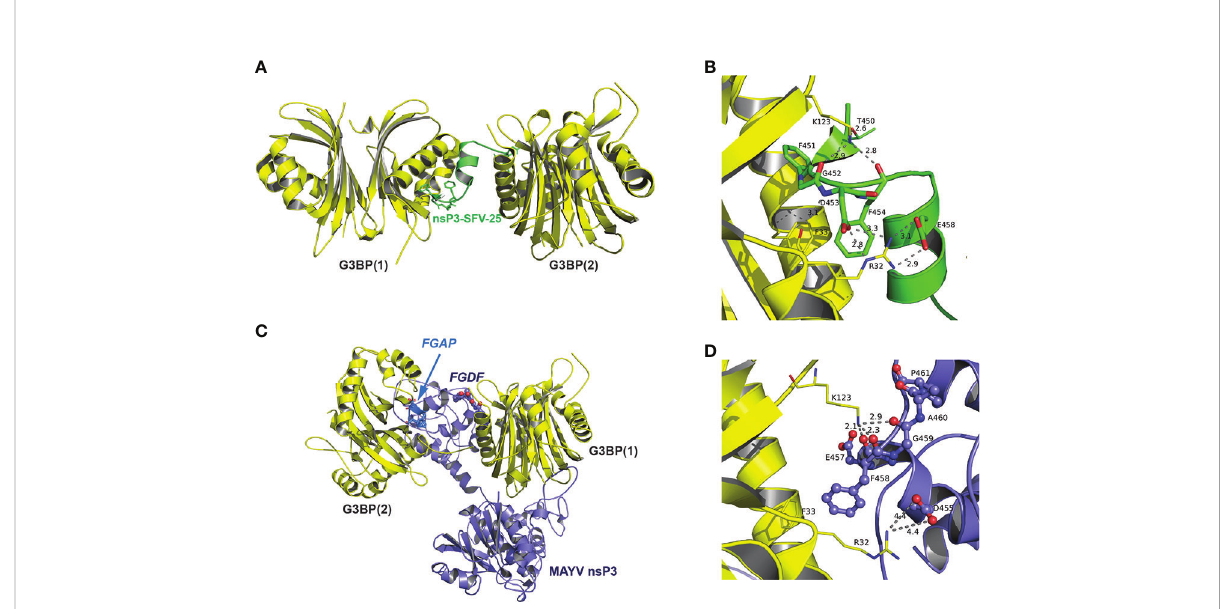
FIGURE 7 Predicted model of interaction between MAYV nsP3 and G3BP. (A) Crystal structure of G3BP dimers (depicted in yellow cartoon representation) in complex with nsP3-SFV-25 peptide (green) from PDB 5FW5 (second dimer added from the asymmetric unit). (B) Close-up view of atomic interactions between G3BP residues and nsP3-SFV-peptide within the FGDF motif. (C) 3D model of nsP3-MAYV (blue)/G3BPs (yellow) complex predicted by rigid docking. (D) Close-up view of interactions between G3BP and residues from FGAP motif of nsP3-MAYV (depicted in ball and